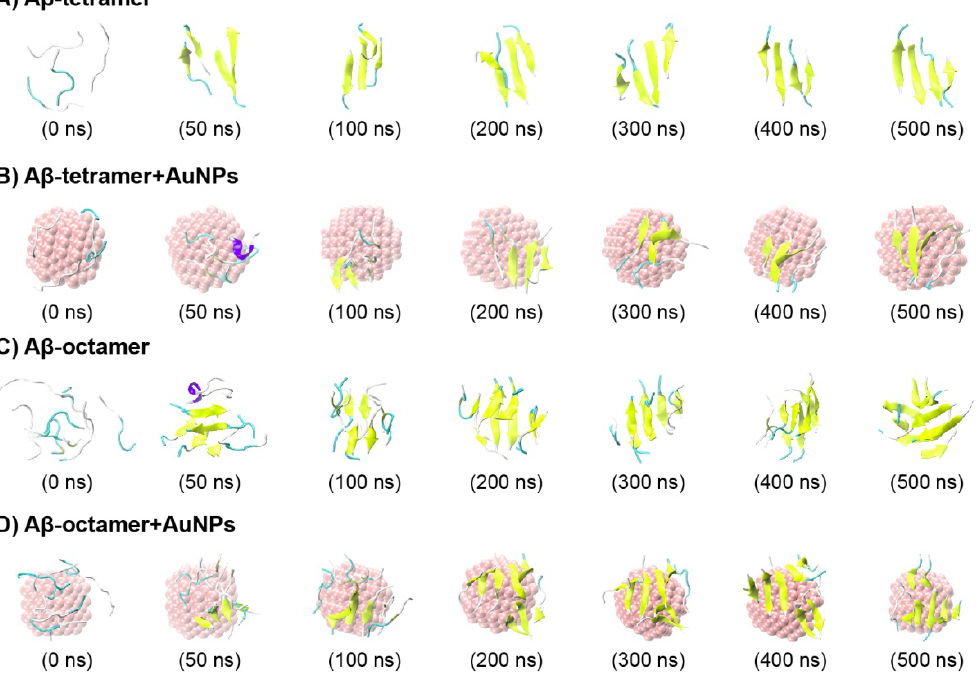
Figure 1. Detailed analysis of a representative molecular dynamics (MD) trajectory starting from the initial state for the A β -tetramer system ( A ), A β -tetramer + AuNPs system( B ), A β -octamer system ( C ), and A β -octamer + AuNPs system ( D ). Snapshots at seven different time points and the top view of the snapshot generated at t = 500 ns. The peptides are represented as cartoons, with the β sheet in yellow, the coil in cyan and the other secondary structure in white and purple. The AuNPs are in van der Waals (vdW) representation in pink. For clarity, counter ions and water molecules are not shown.